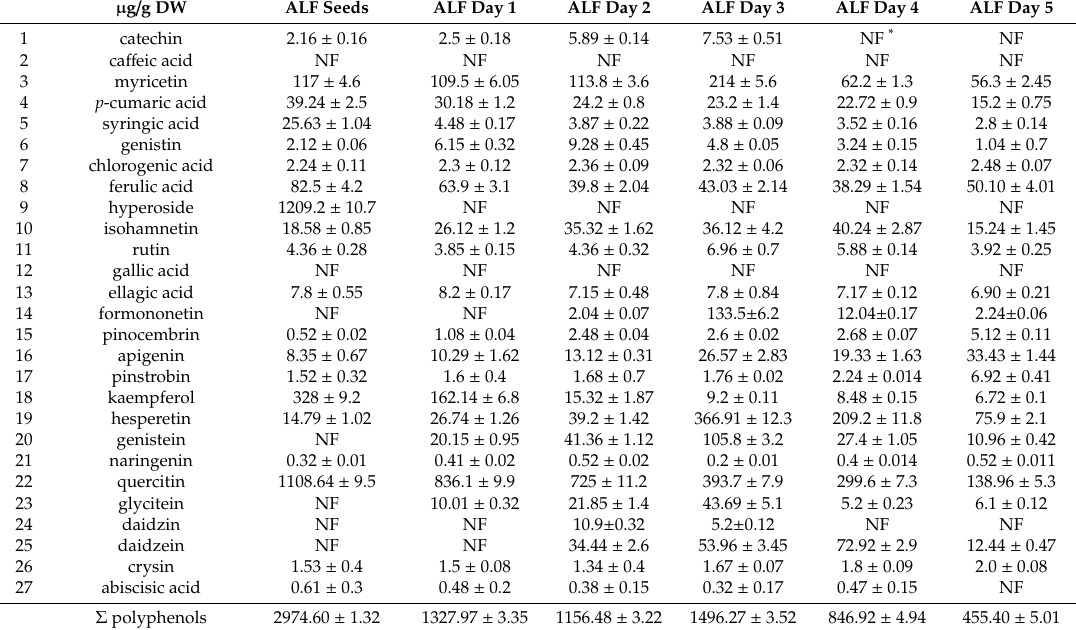
Table 5. The results of the quantitative analysis for alfalfa sprouts in µ g per g of dried weight vegetal material (alfalfa sprouts samples coded as: ALF – alfalfa, day 1-first day of germination, day 2-second day of germination, day 3-third day of germination, day 4-fourth day of germination, and day 5-fith day of germination).